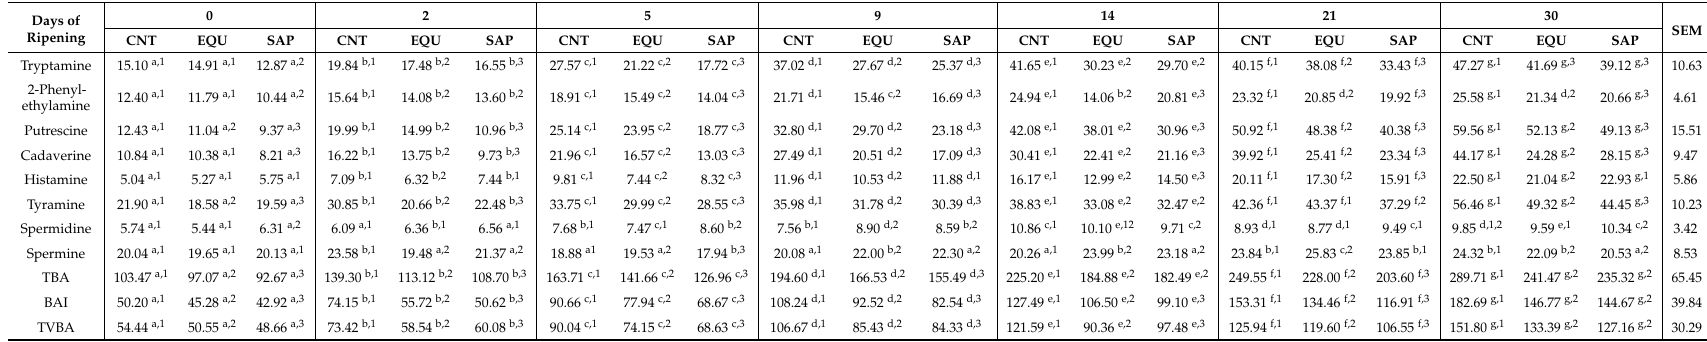
Table 6. Evolution of the biogenic amines (mg / kg of TS) along the manufacturing process of Galician chorizo made without and with starter cultures (means of three replicates in each sausage group).